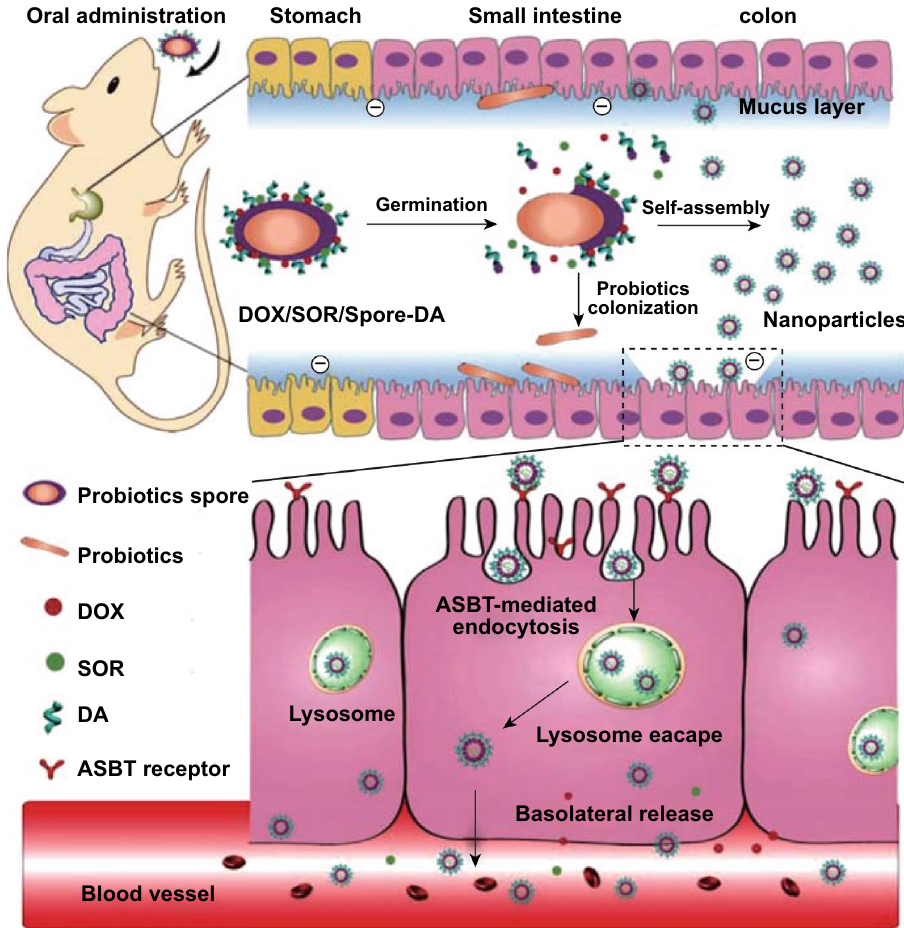
Fig. 10 Schematic illustration of the Spore-Based Oral Autonomous Nanoparticles and its transepithelial transport mechanism. The chemo- therapeutic drugs DOX and sorafenib (SOR), which are used as a synergistic treatment of cancer, are co-loaded in spores to construct an autono- mous NPs generator (DOX/SOR/Spore-DA). The generator can continuously produce large amounts of DOX/SOR/Spore-DA NP in the GIT microenvironment. Subsequently, NP is effectively taken up by epithelial cells through the apical sodium-dependent bile acid transporter-medi- ated endocytic pathway, which can overcome various biological obstacles of the intestinal epithelium and increase the release of basolateral drugs, thereby improving the bioavailability of drugs. Reprinted with permission from Ref.